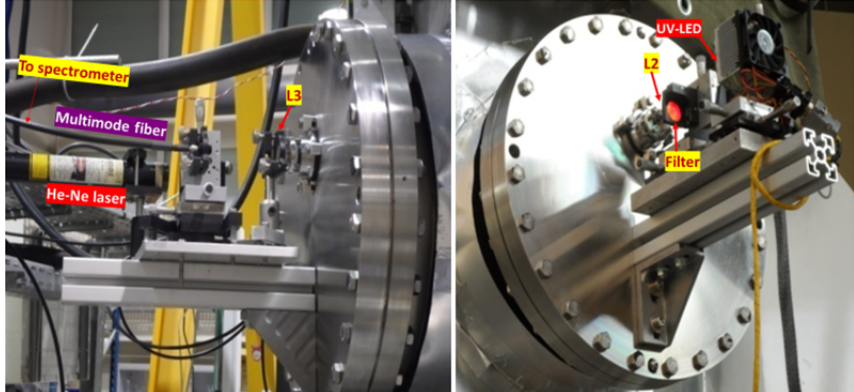
Figure 2. View of the IBBCEAS installation on the CESAM simulation chamber flanges. L2 and L3 are BK7 focus lens. M1 and M2 are two concave high-reflectivity